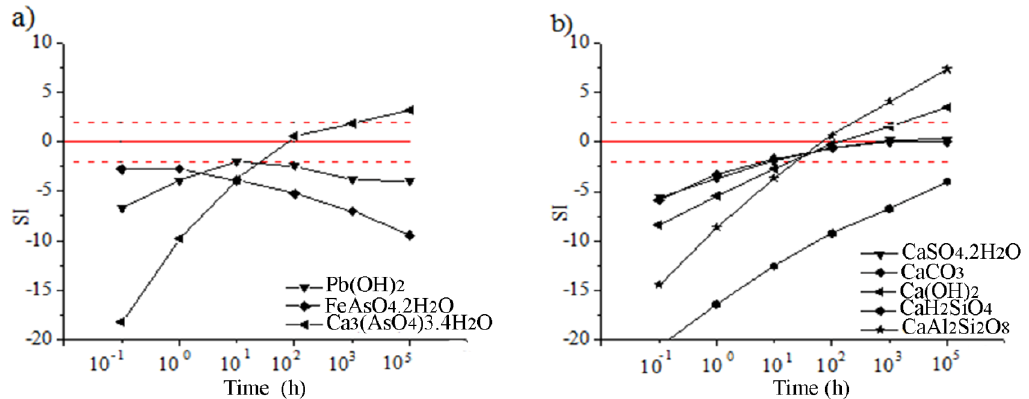
Figure 5. Saturation indices of minerals: ( a ) Pb and As, and ( b ) Ca as a function of leaching time (modeling results for S25).